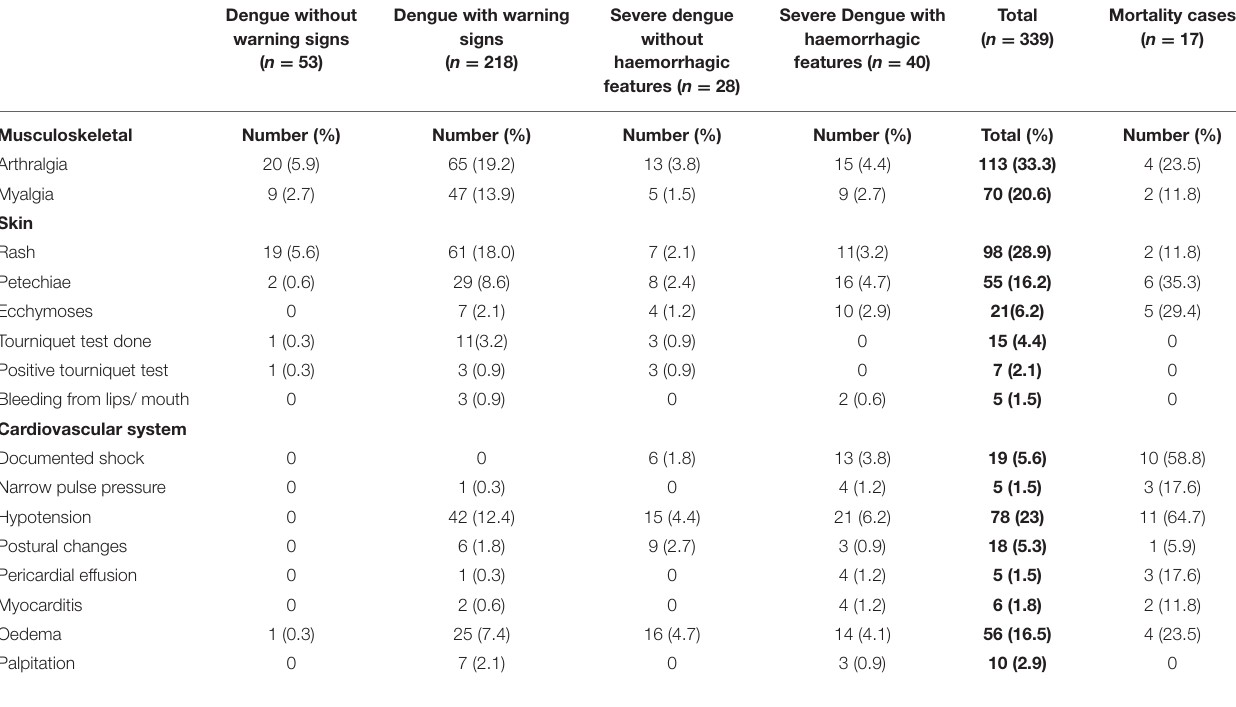
TABLE 3B | Clinical manifestations in pediatric patients hospitalized with suspected and confirmed dengue in the 2018–2019